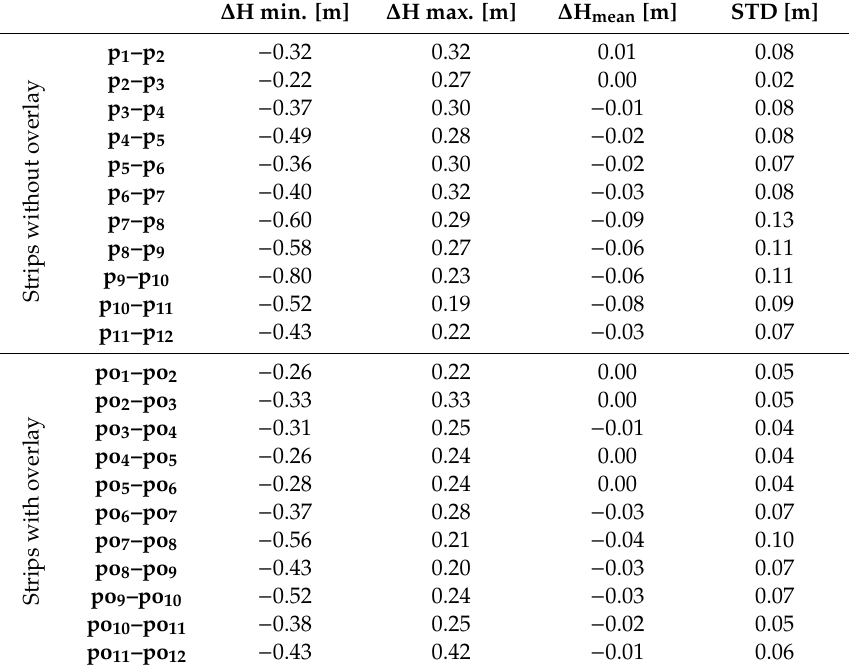
Table 6. Height differences between strips in methodology v1. (Where: H—height, STD—standard deviation). ∆ H min. [m] ∆ H max. [m] ∆ H mean [m] STD